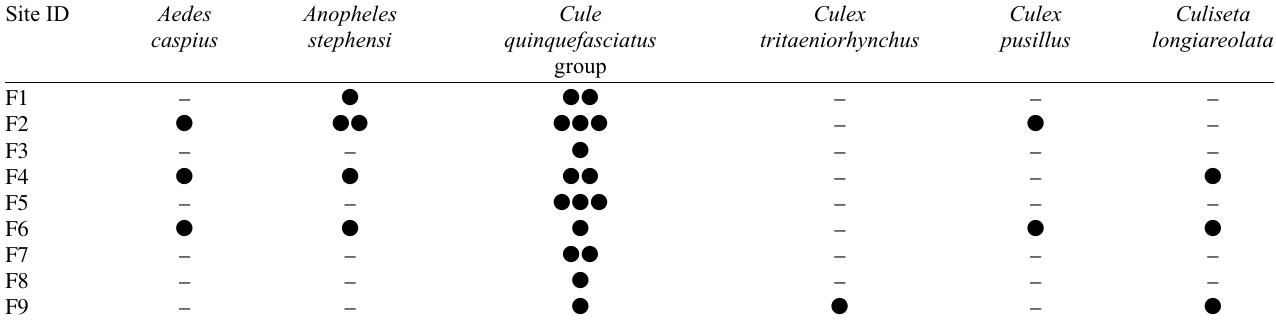
Table 2. Relative abundance of mosquito species collected in the longitudinal adult monitoring, per site, August 2017 – September 2018, according to one sample per month per site. One black dot = 1 – 10 individuals; Two black dots = 11 – 50 individuals; Three black dots = >50